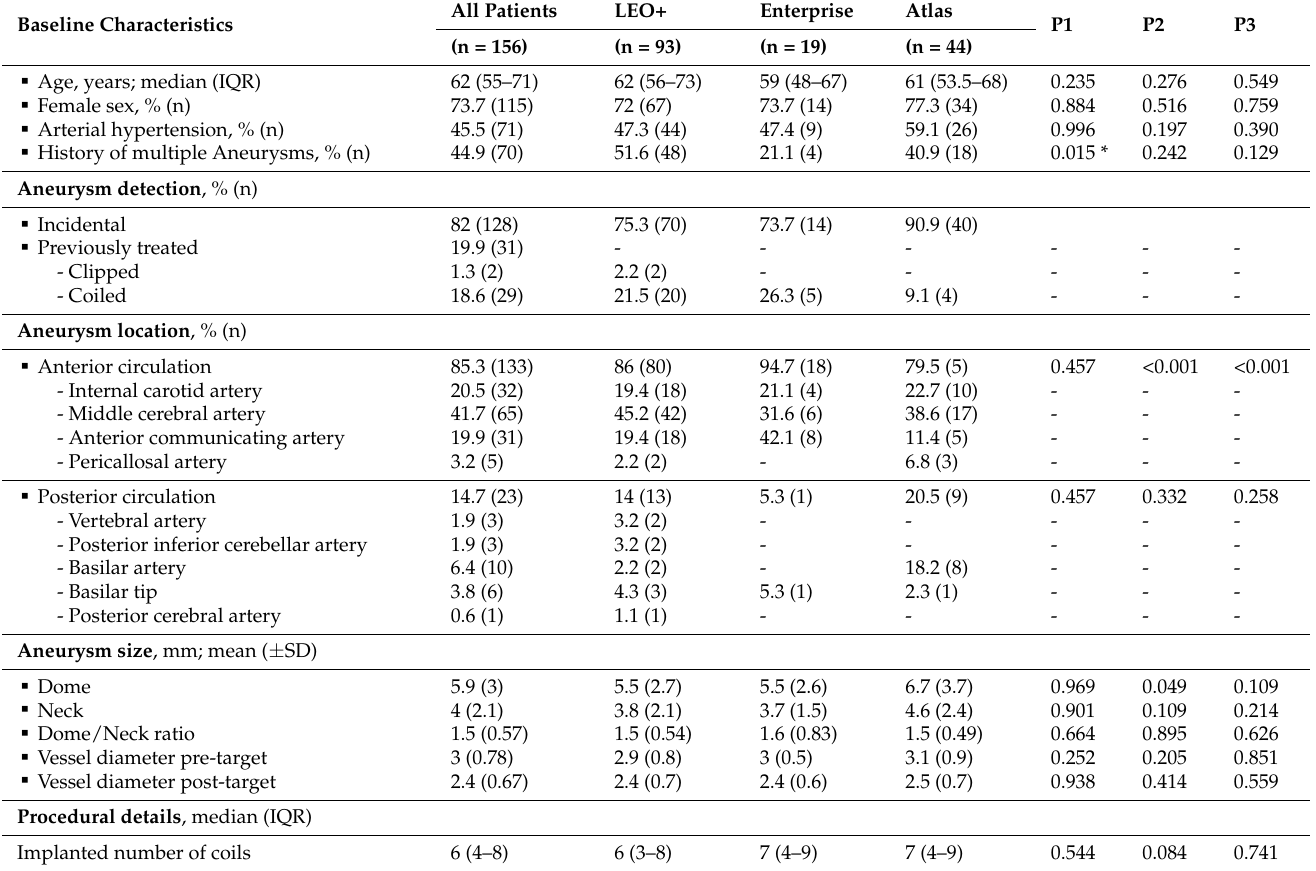
Table 1. Baseline characteristics and anatomical aneurysm details grouped by stent model.